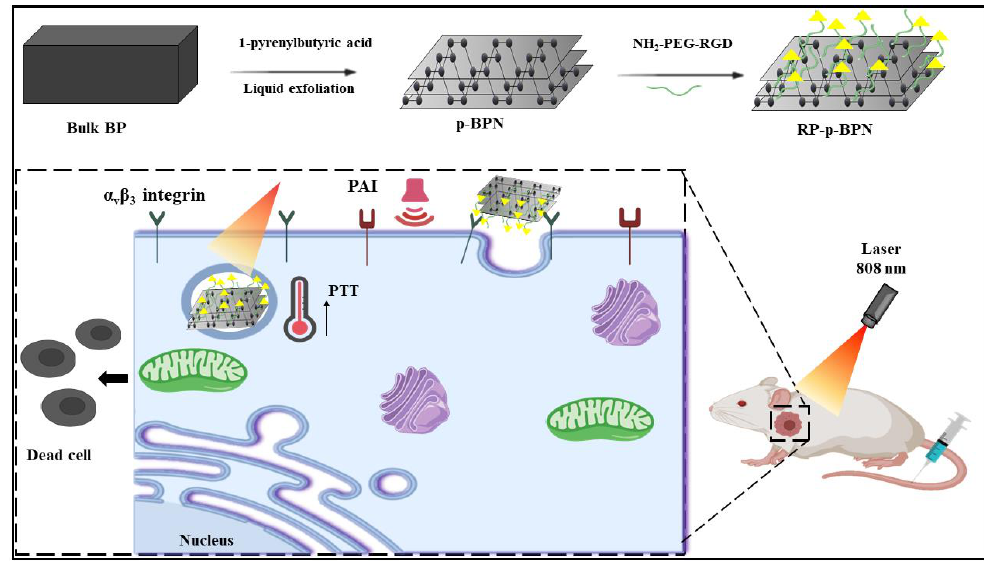
Figure 7. Schematic representation of red phosphorus (RP)-p-Poly-L-lysine (PLL)-coated BP nanosheet (BPNS) synthesis and its therapeutic application in cancer imaging and therapy.